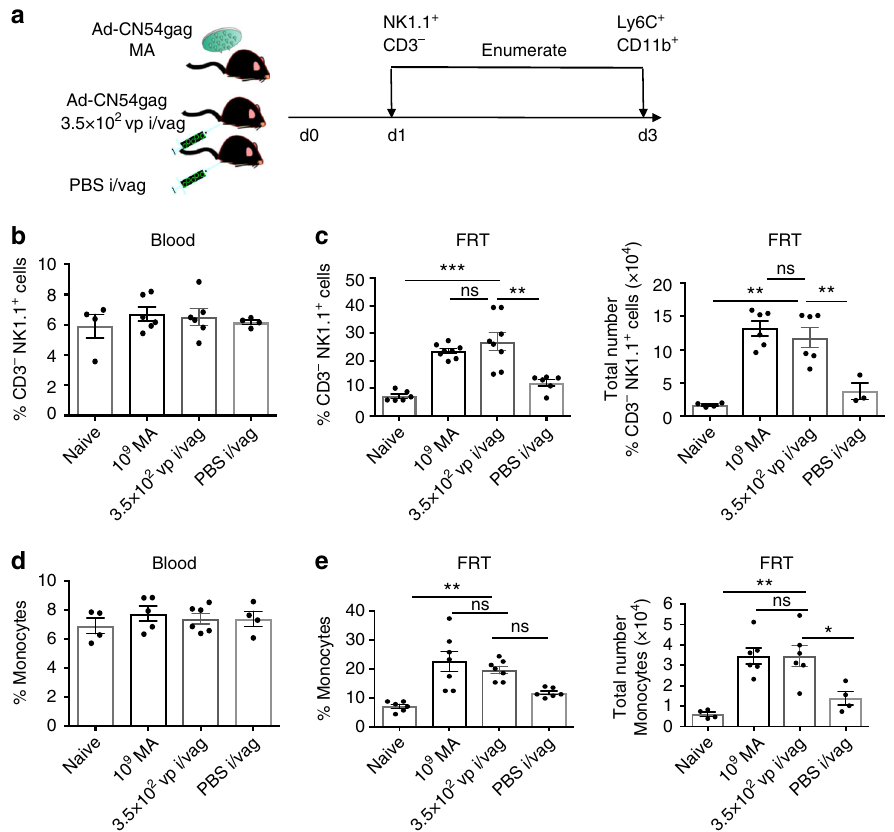
Fig. 7 Ad vector biodistributed after skin immunisation recruits group 1 ILCs and monocytes into the FRT. a Experimental design. Mice were immunised with Ad-CN54 gag by MA delivery to the skin (1x10 9 vp) or by injection to the vaginal mucosa (i/vag) with 3.5 × 10 2 vp (equivalent to the biodistributed Ad vector dose). Control mice were injected PBS (i/vag). After 1 day, NK1.1 + CD3 − (ILC1) and after 3 days (monocytes) were enumerated from peripheral blood and FRT tissues. b Frequency of NK1.1 + CD3 − ILC1 in peripheral blood. c Frequency (left panel) and absolute number (right panel) of NK1.1 + CD3 − ILC1 in FRT. d Frequency of monocytes in peripheral blood. e Frequency (left panel) and absolute number (right panel) of monocytes cells in FRT. Data are from two independent experiments ( n = 4 – 7 per experimental group). p > 0.05 (ns), * p < 0.05, ** p < 0.01, *** p < 0.001 by one-way ANOVA, error bars show